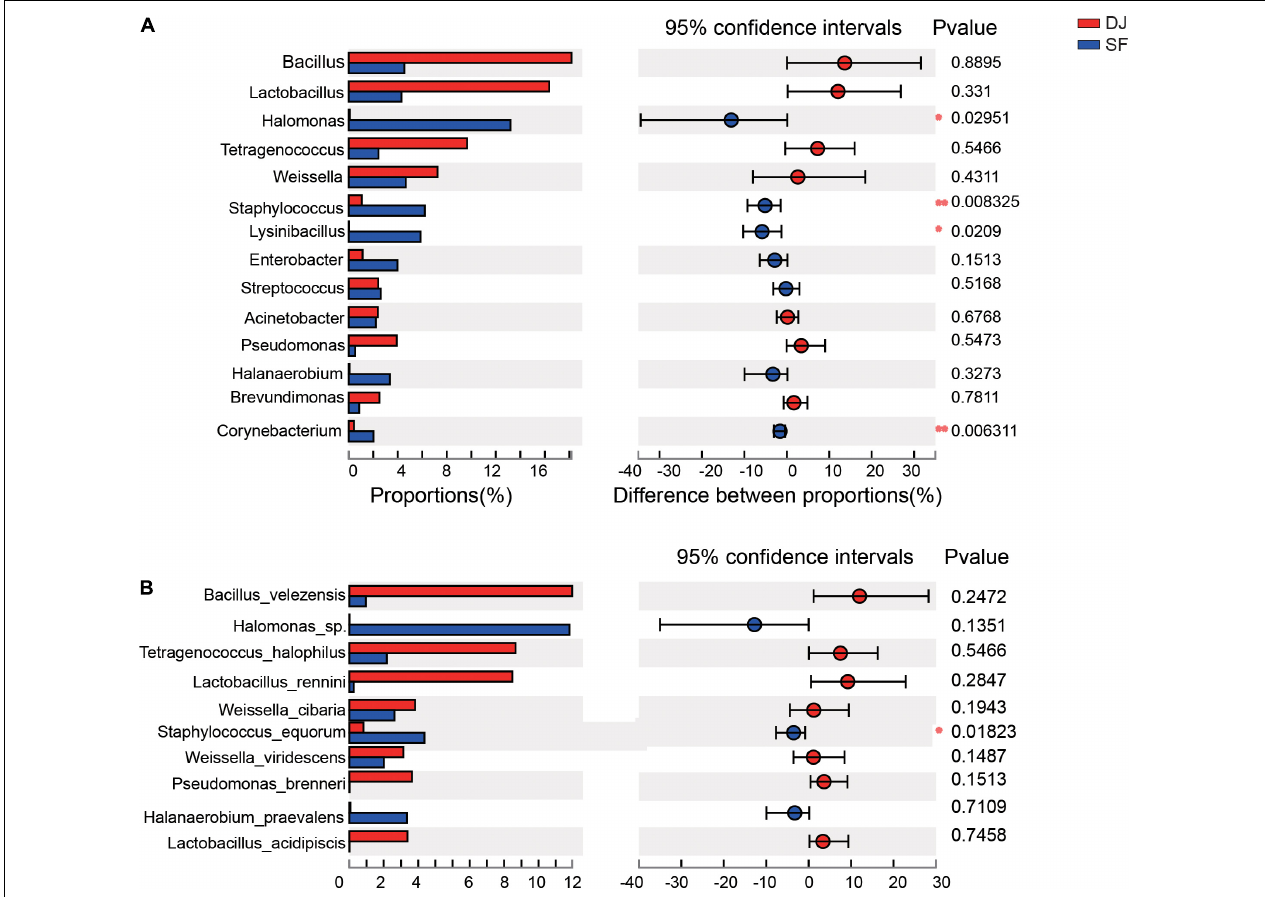
FIGURE 5 | Linear discriminant analysis effect size of Dajiang and Sufu. (A) Histogram of the microbiota at the genus level. (B) Histogram of the microbiota at the species level. * P < 0.05, ** P < 0.01.